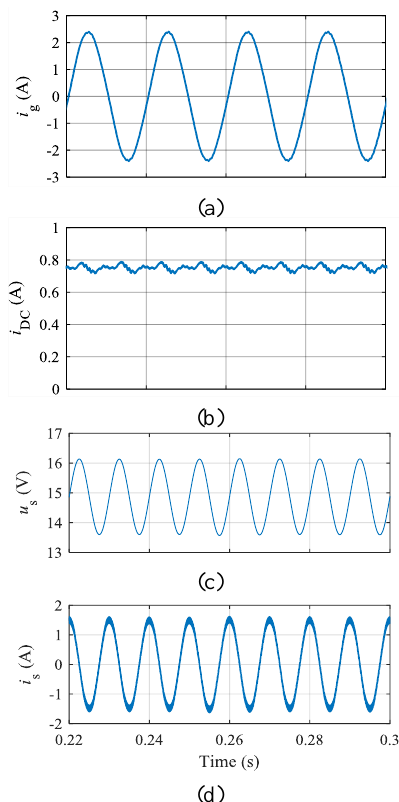
Figure 14. With φ 1 = π /2, θ = π /2, ( a ) i g ; ( b ) i DC ; ( c ) the power decoupling capacitor C s voltage u s ; and ( d ) the power decoupling capacitor C s current i s .